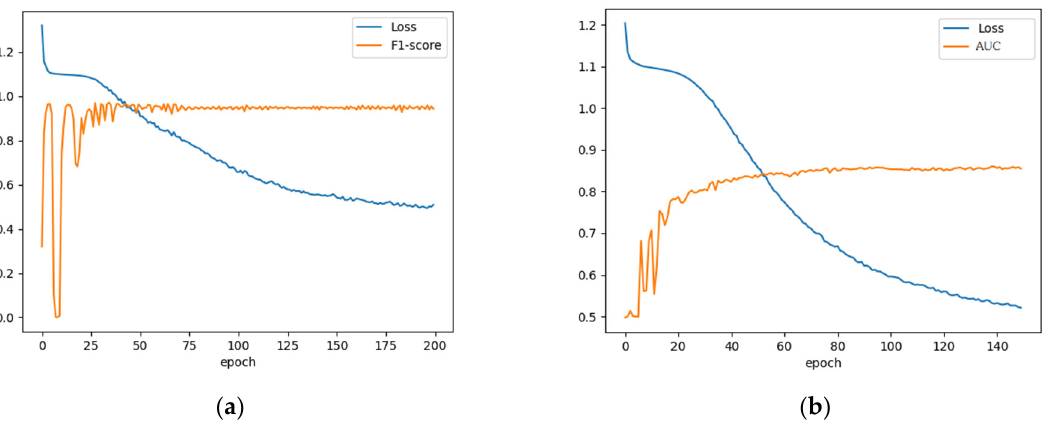
Figure 5. ( a ) Bitcoin-OTC with train loss and F1-scoreres; ( b ) Bitcoin-OTC with train loss and AUC.